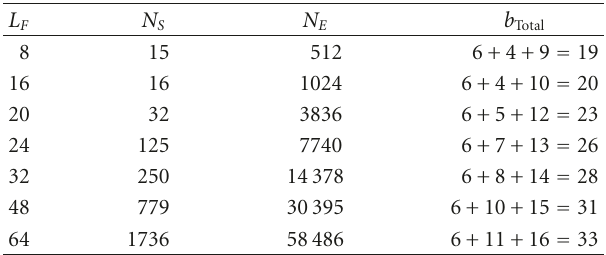
Table 1: Variation of total number of bits with respect to frame